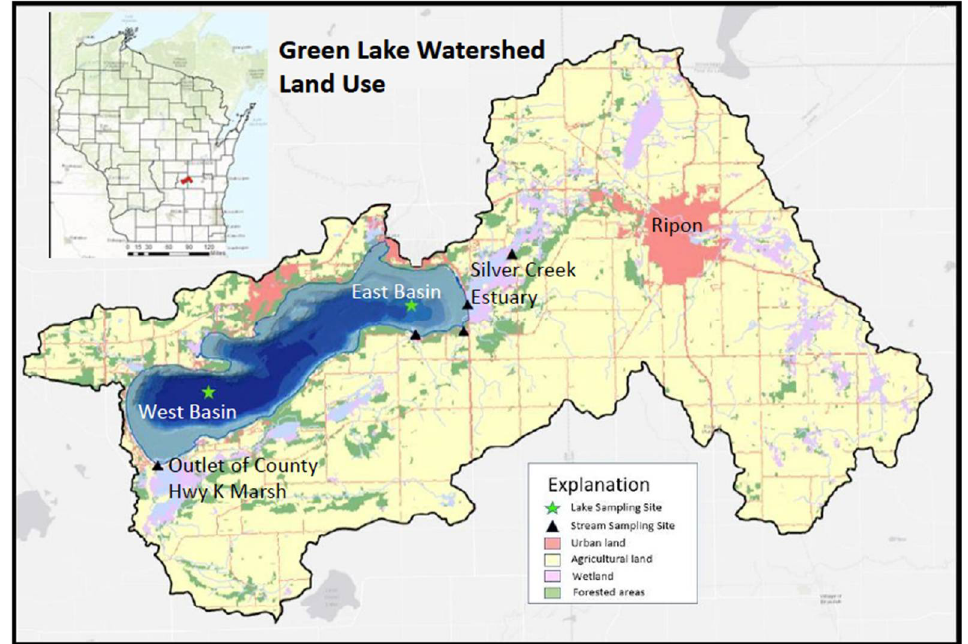
Figure 2. Green Lake watershed land use [6].